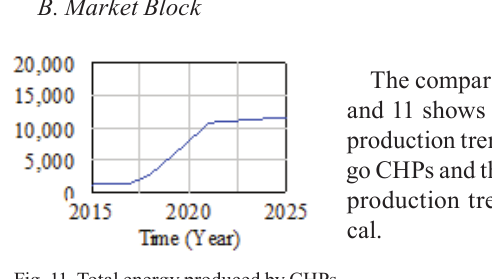
Fig. 11. Total energy produced by CHPs (Latvenergo CHPs + small CHPs).